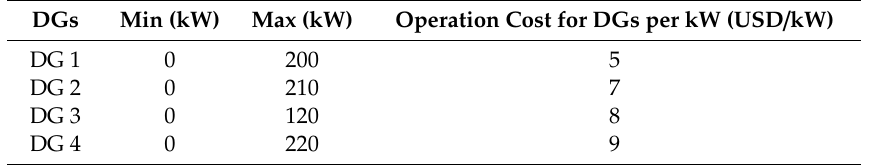
Table 1. Parameters of